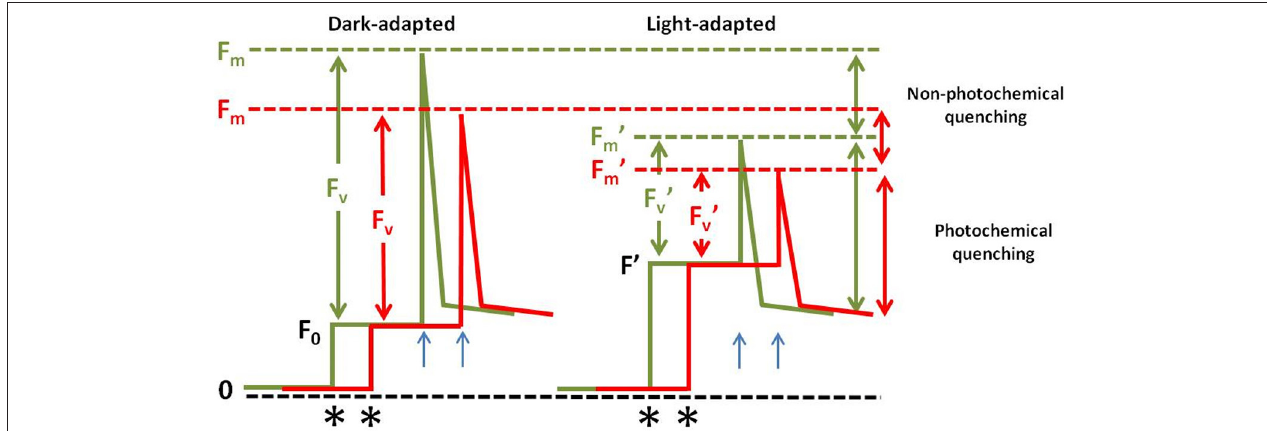
FIGURE 2 | Fluorescence emission under drought stress. Fluorescence dynamics on dark- or light-adapted leaves when cultivated under normal conditions (green lines) or under drought stress (red lines). When leaves are dark-adapted the Q A (Plastoquinone) is maximally oxidized and the PSII is called “open.” The exposure of the leaf to a weak measuring light (asterisks mark the point where the measuring light was turned on) results in a minimal level of measured fluorescence (F 0 ). A saturating pulse is emitted (blue arrows) and F m , or maximum fluorescence is recorded. The difference between F m and F 0 in called F v or variable fluorescence. The Fv/Fm is called maximum quantum yield of Q A reduction or PSII photochemistry. When the leaf is light adapted, the minimal level of fluorescence shifts above the original background (F ′ ). In this situation less Q A is oxidized and when a light pulse is emitted the maximum fluorescence for light adapted leaves (F ′ m ) is recorded and its level is lower that the F m because when the plants are subjected to stress the photochemical quenching is diminished due to the photoinativation of the PSII leading to a higher level of the non-photochemical quenching (NPQ) or the dissipation of energy through heat. F ′ v is calculated as F ′ m -F ′ . F ′ v /F ′ m is called maximum PSII efficiency. This parameter is used to measure the contribution of the NPQ on the observed changes on the PSII operation.